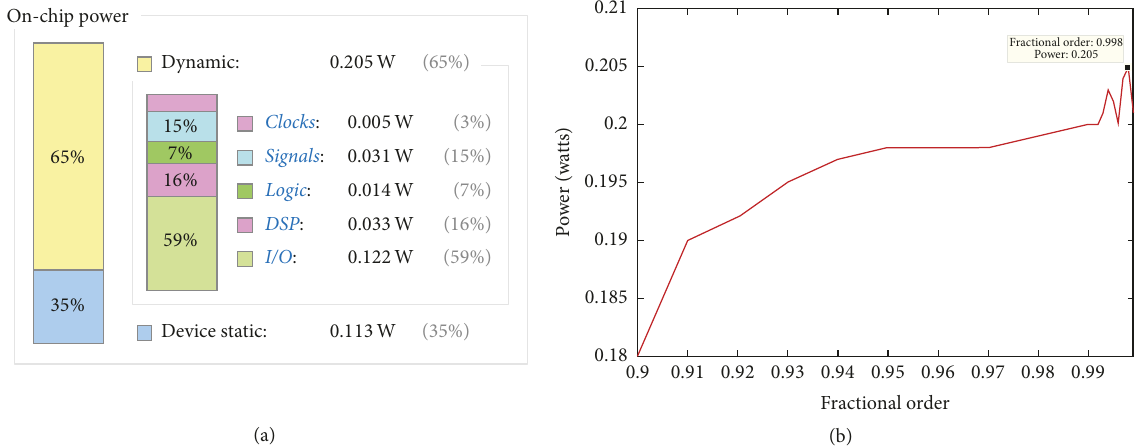
Figure 14: (a) Power utilized and (b) power utilization versus fractional order of FOPF.